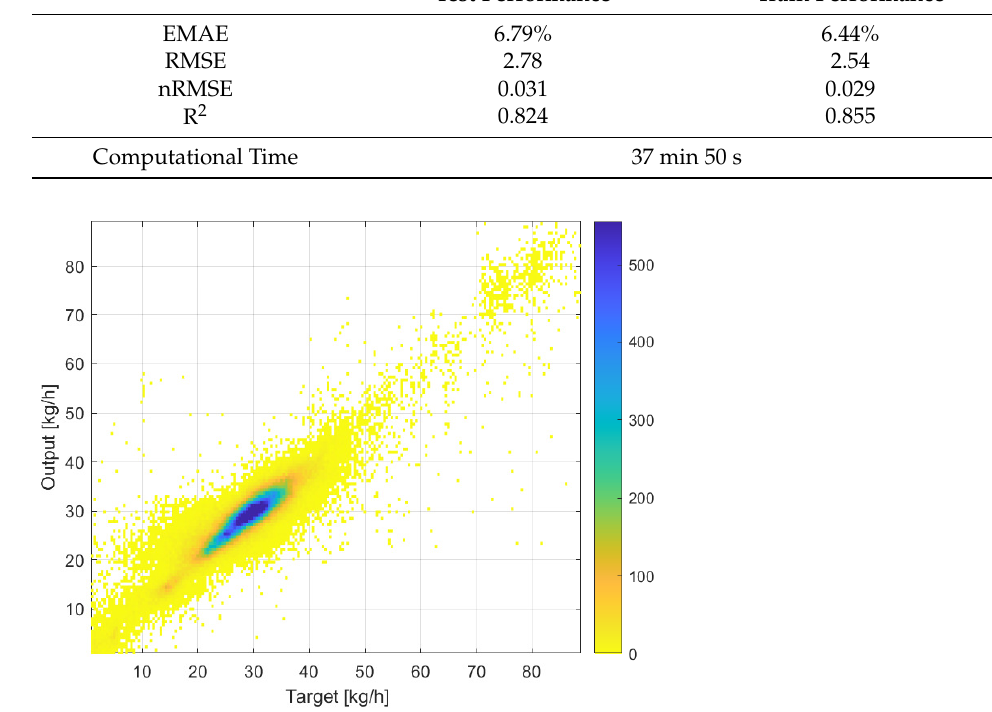
Figure 4. Regression plot of the output vs. the target for the prediction of the SO 2 flow rate that goes to the Claus unit, with the data dispersion highlighted.